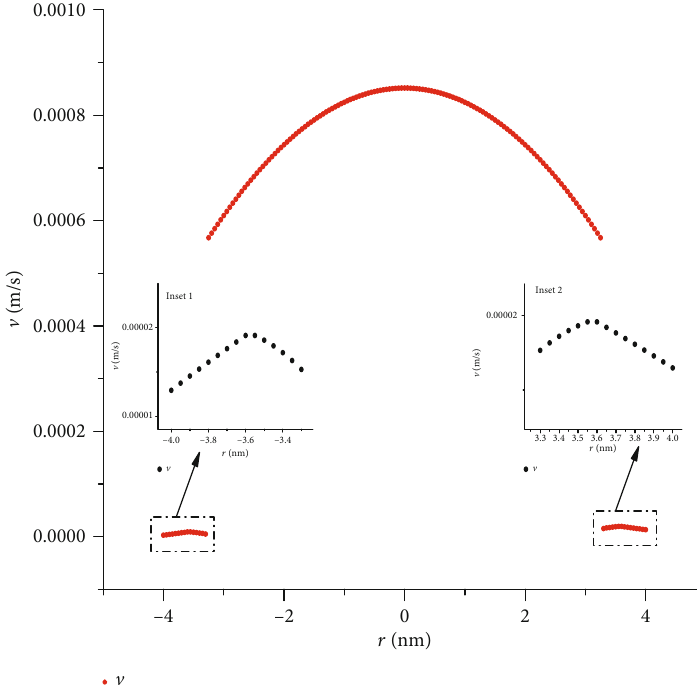
Figure 4: Gas and water velocity pro fi le of the proposed model, and the insets show the enlargement of the water fi lm velocity on the left and right. P = 50 MPa, T = 350 K, ∅ = 0 : 9 , h